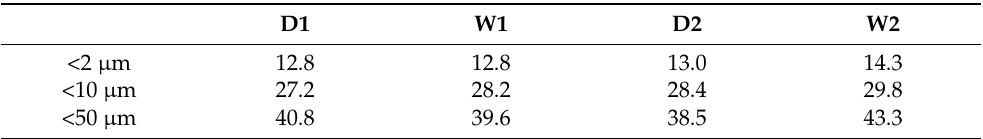
Table A7. Aggregate representation percentage in the sediment depending on initial condition, slope 30° [%].